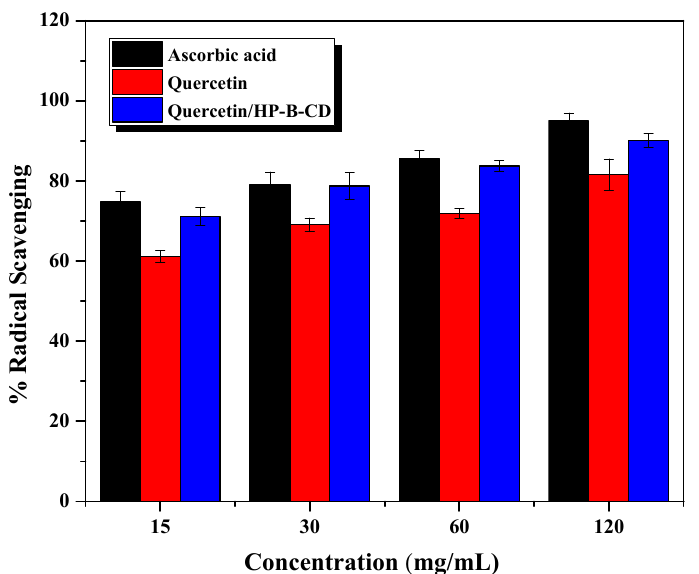
Figure 6. Scavenging activity of ascorbic acid, quercetin and quercetin/ HP- β -CD as determined by DPPH assay. Values expressed as mean ± standard deviation ( n = 5).